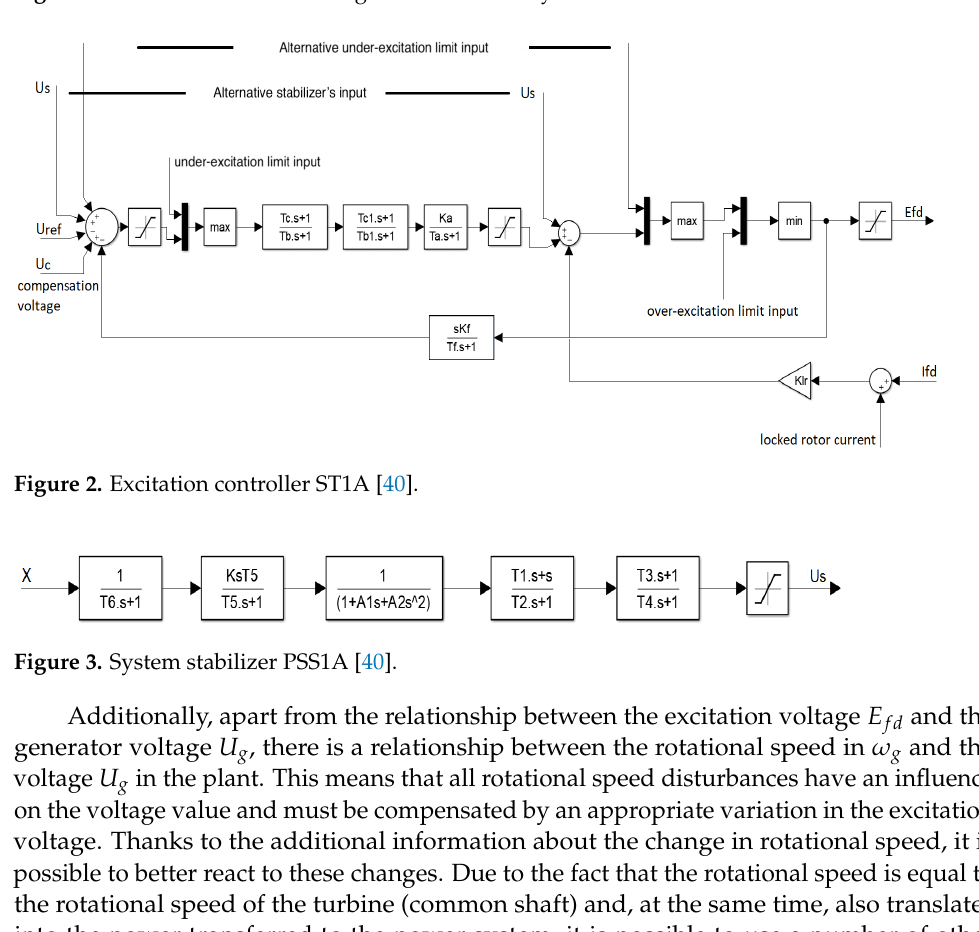
Figure 1. Structure of the classical generator control system.